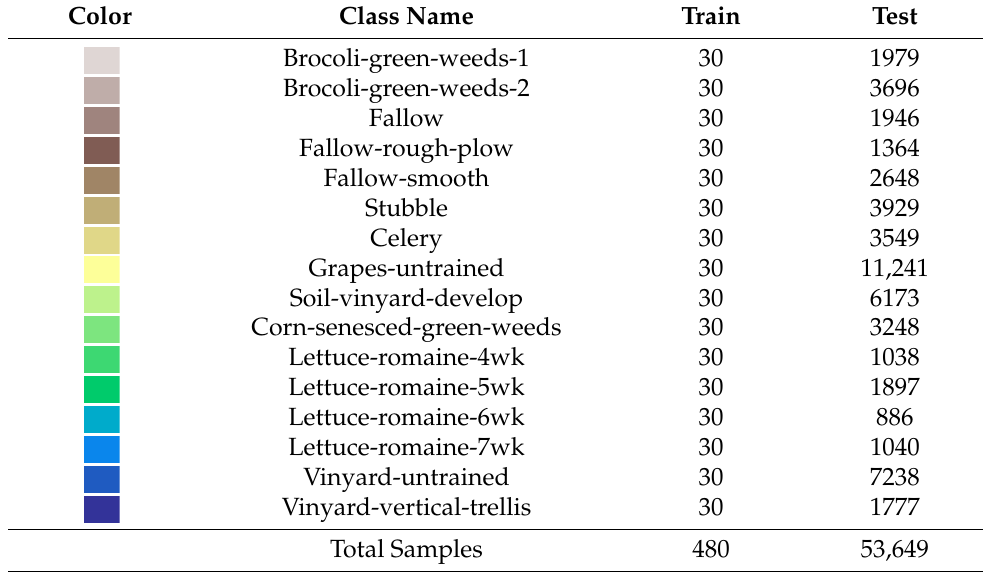
Table 4. The number of training and test samples in SV dataset.